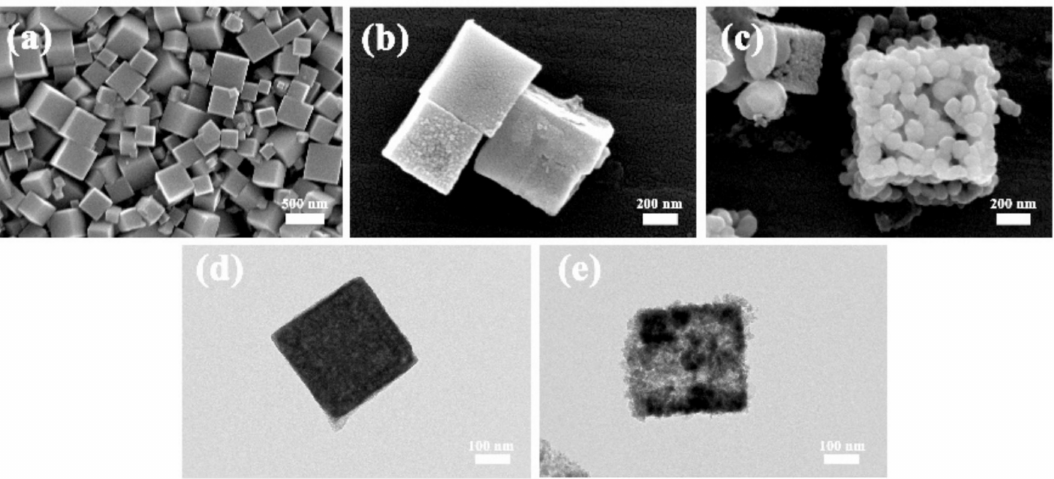
Figure 3. SEM images of ( a ) precursors blue, ( b ) Fe 2 O 3 -500 and ( c ) Fe 2 O 3 -700. TEM images of ( d ) Fe 2 O 3 -500 and ( e ) Fe 2 O 3